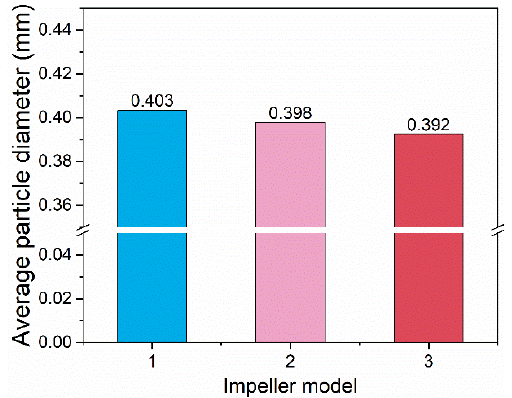
Figure 5. The vortex depth and heigh.